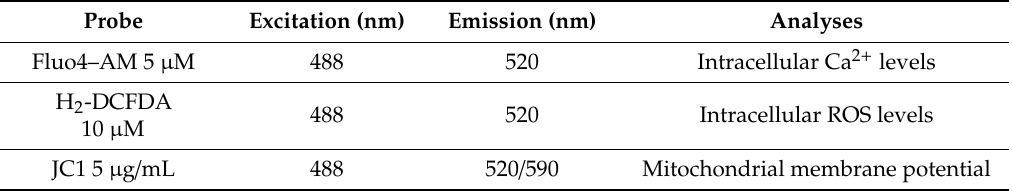
Table 1. Fluorescence probes used for intracellular